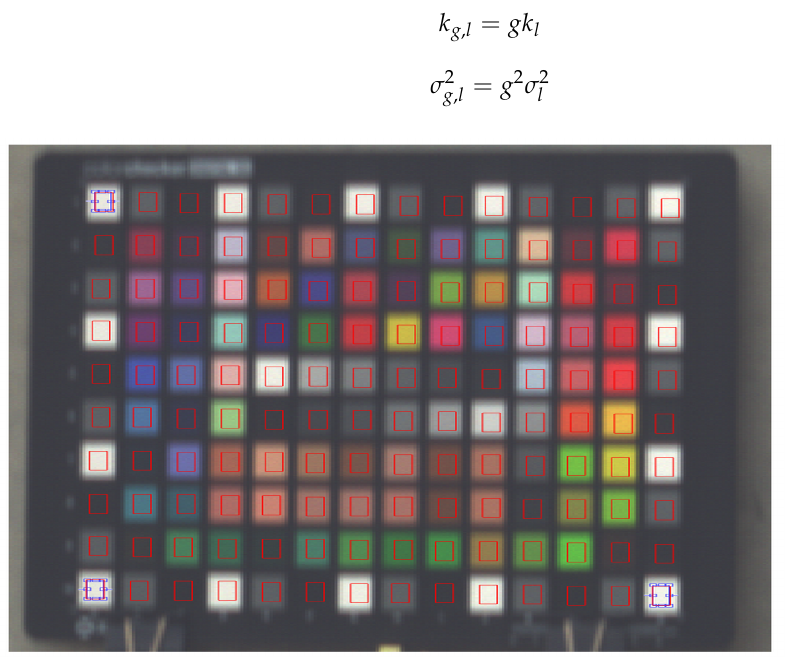
Figure 2. The colorchecker and the cropped ROI used for noise parameter calibration.